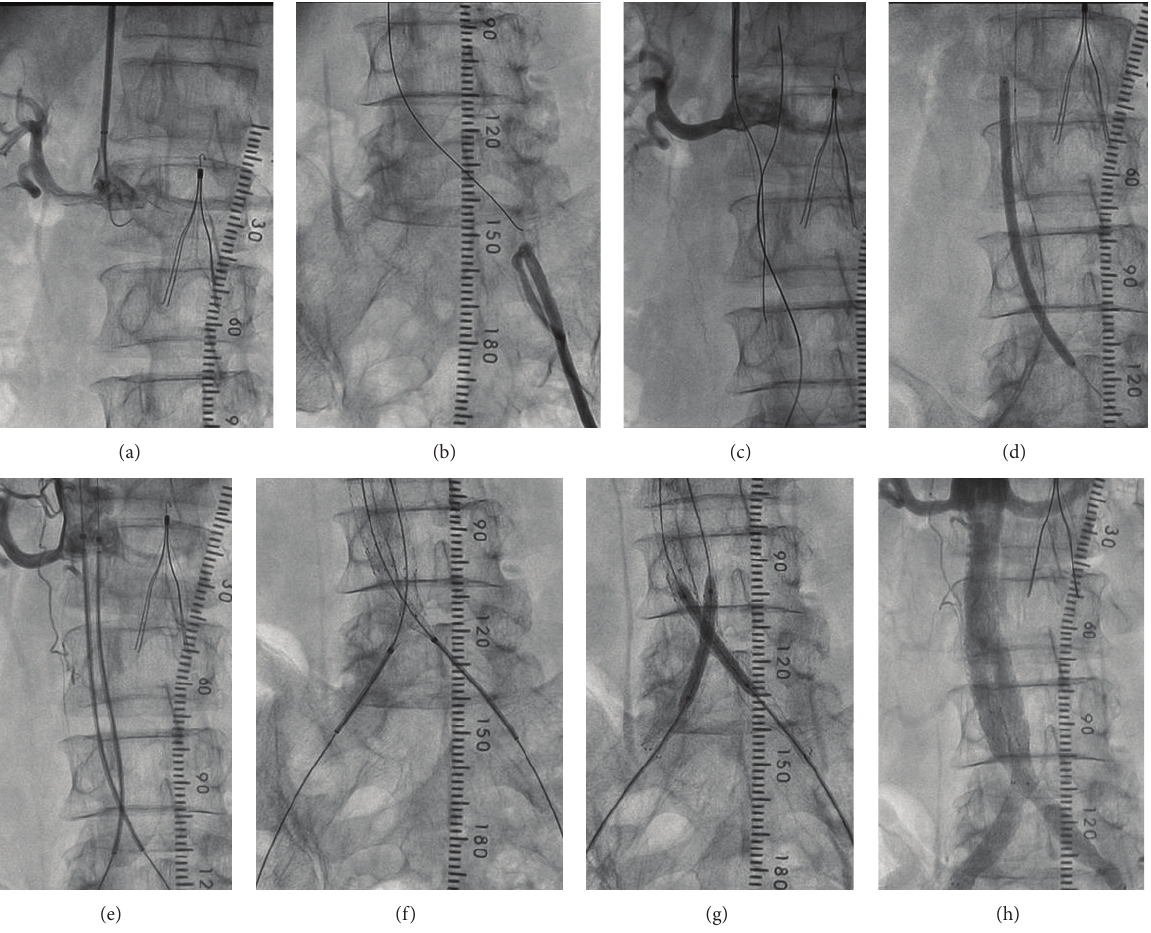
Figure 4: (a)Theproximal fibrouscap of theocclusion siteof terminal aorta was penetrated by usinga multipurposecatheter and a 0.035-inch Radifocus guidewire. (b) Treasure XS12 was crossed from the aorta to the left external iliac artery. (c) Another Treasure XS12 was advanced from the right femoral artery to the aorta. (d) The occluded segments of the bilateral iliac arteries were predilated with either of the two 4.0 mm balloons. (e, f) An Epic 10mm (98mm) and a 10mm (80mm) stent were inserted from the right common iliac artery and advanced to the aorta. Also, an Epic 10mm (98 mm) and a 10mm (60 mm) stent were inserted in the left iliac artery from the left common iliac artery and advanced to the aorta. (g) The postdilatation of the bilateral stents was performed simultaneously with two 5.0 mm balloons. (h) The final